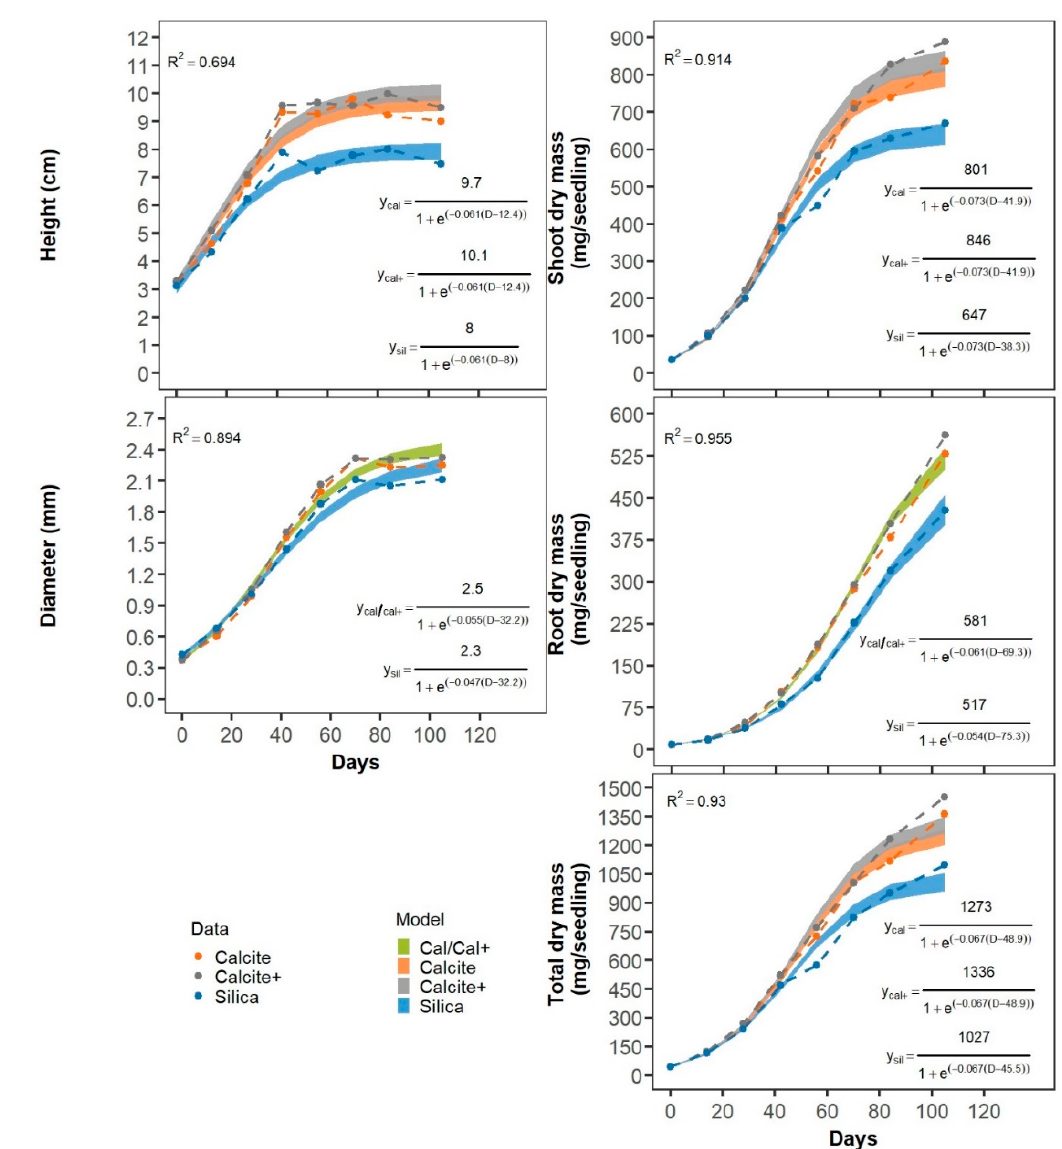
Figure 8. Evolution of the means and logistic models adjusted for each of the growth variables of white spruce seedlings (1 + 0), depending on the treatments (silica, calcite and calcite+). The width of each band corresponds to the 95% confidence interval. As the parameters of the calcite and calcite+ treatments did not differ significantly from each other, a single logistic model was generated by combining the data from these two treatments. The models were adjusted using all the data (n = 600 seedlings/treatment for height and diameter, and n = 200 composite samples of three seedlings/treatment for shoot, roots and total dry masses.